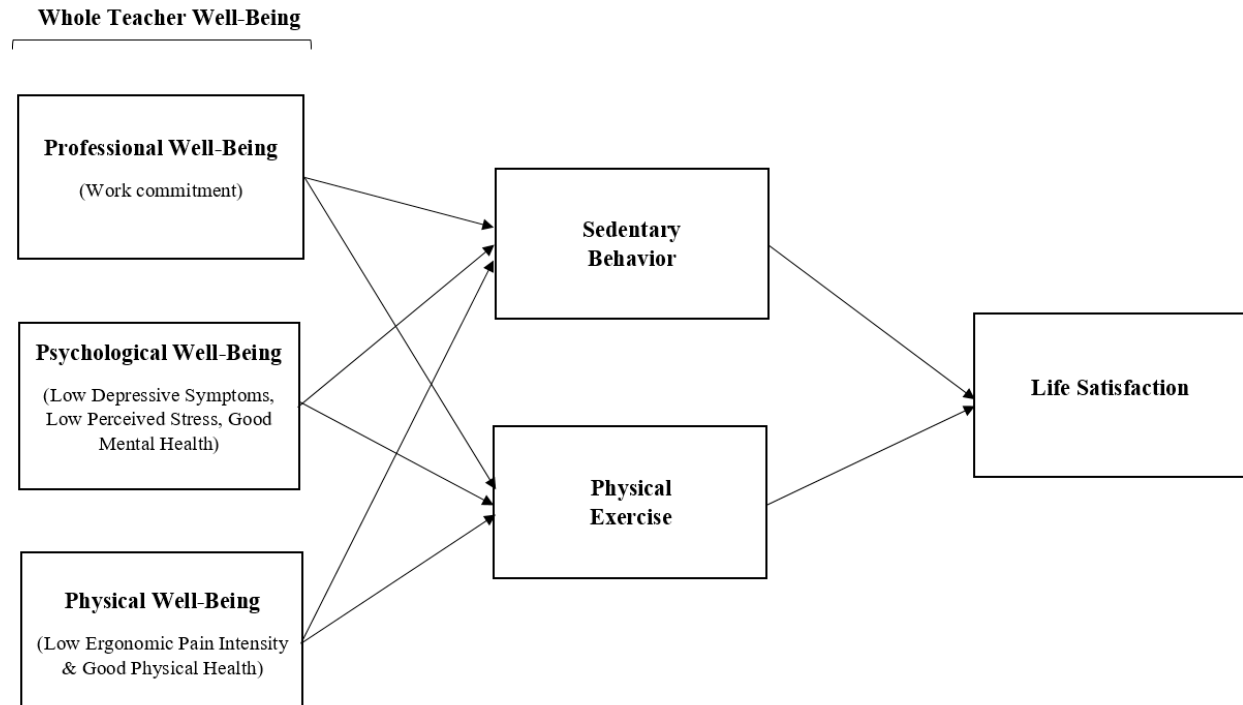
Figure 1. Well-being Mediation Model of Physical Activity and Life Satisfaction.